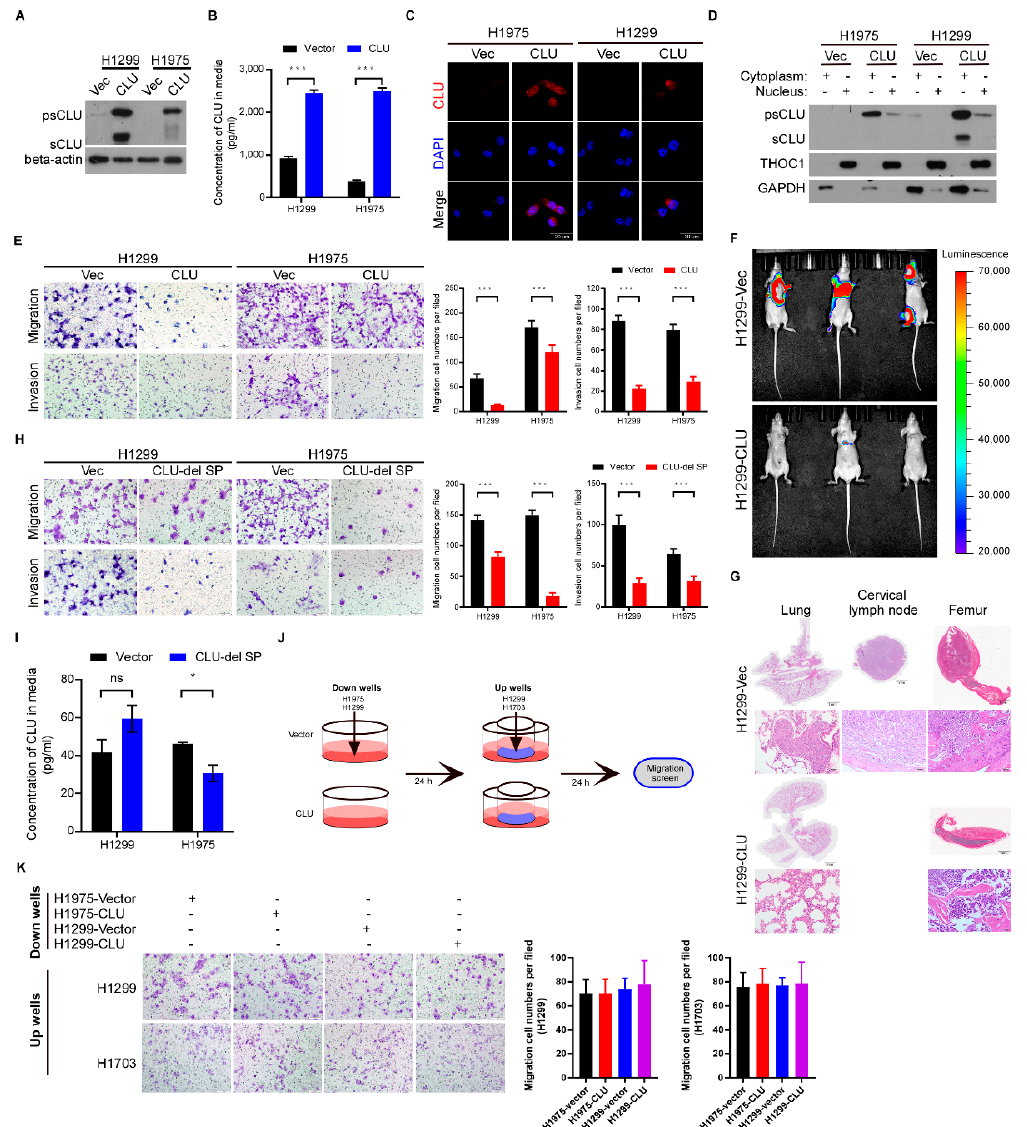
Figure 2. CLU, especially cytoplasmic CLU, suppresses invasion, migration and metastasis. ( A ) The protein levels of psCLU and sCLU in H1975 and H1299 vectors (vec) and CLU-overexpressing cells. GAPDH was used as a loading control. ( B ) ELISA assay shows the concentration of sCLU in H1975 and H1299 vec and CLU-overexpressing cells. ( C ) Representative micrographs of the staining of intracellular CLU in H1975 and H1299 cells. ( D ) WB analysis of subcellular distribution of psCLU and sCLU in H1975 and H1299 cells. ( E ) Representative images of Transwell assay and relative quantification of the migration or invasion cells in H1299 and H1975 cells. ( F , G ) H1299-Vec or H1299-CLU cells were injected via cardiac ventricle into nude mice (n = 5 per group). Representative bioluminescent images of systemic metastasis and ex vivo organ metastases are shown ( F ), H&E histologically confirmed tumor cells in bone and brain tissue ( G ). ( H ) Representative images of Transwell assay and relative quantification of the migration or invasion cells in H1975-Vec, H1975-CLU-del SP cells, H1299-Vec and H1299-CLU-del SP cells. ( I ) ELISA assay shows the concentration of CLU in indicated cells. ( J ) Vector-control or CLU-overexpressing cells were seeded in the down wells and cultured with the supernatant medium of H1703 or H1299 cells in the up wells. ( K ) Representative images of Transwell assay and relative quantification of migration cells in H1299 and H1703 cells stimulated by indicated supernatant samples. Results are presented as mean ± SD, * p < 0.05, *** p < 0.001, ns means no significance.